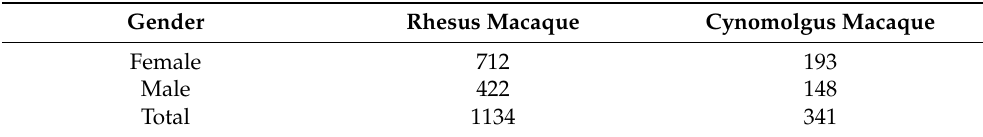
Table 1. Included number of animals by gender and